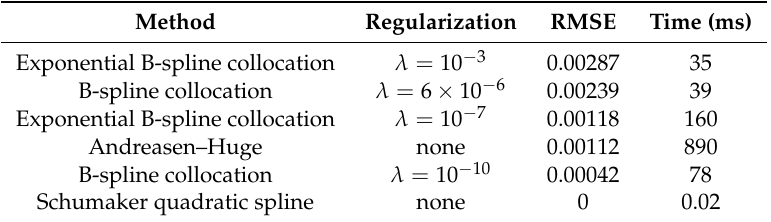
Table 2. Root mean square error (RMSE) of the collocation method implied volatilities against